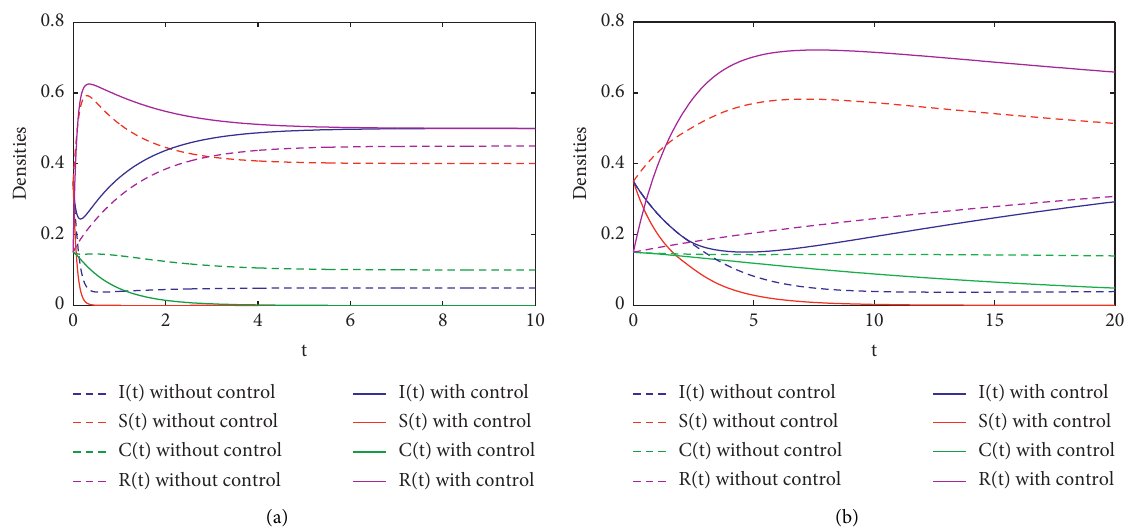
Figure 6: (a) The impact of optimal control without time delay. (b) The impact of optimal control with time delay.